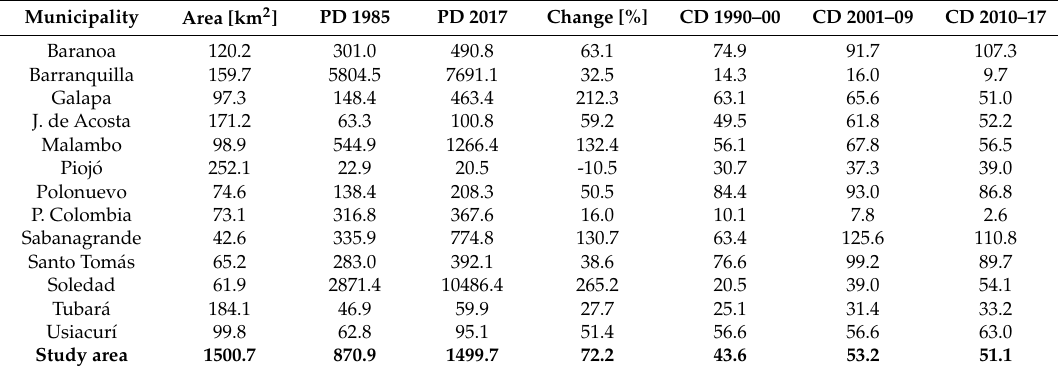
Table 8. Population density (PD) and mean cattle density (CD) per km 2 in the study area for 1985 to 2017 and 1990 to 2017, respectively